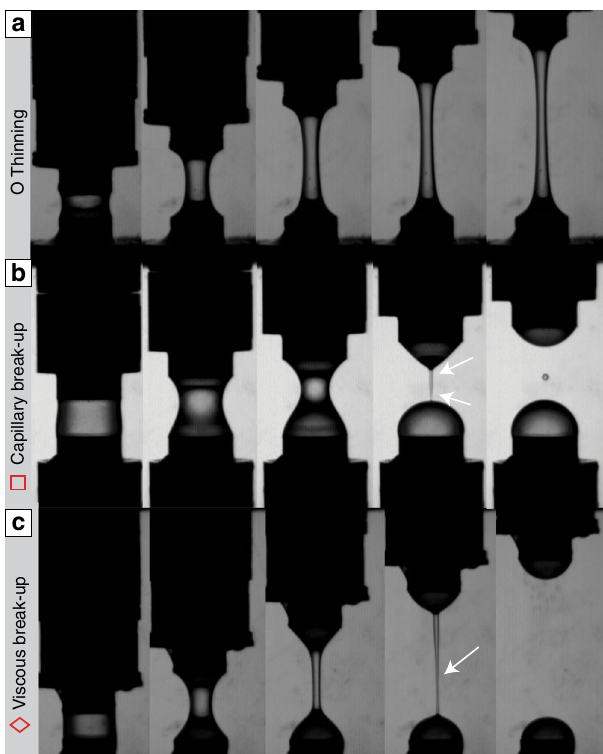
Fig. 2 Representative images showing the three styles of behaviour observed. Speci fi cally, these image stills are from experiments that used a a 5 wt.% dilution of golden syrup, b a 30 wt.% dilution of golden syrup and c a 20 wt.% dilution of golden syrup. Images taken at 0, 0.02, 0.04, 0.06 and 0.08 s into the deformation. In experiments a and c the initial droplet had a 4 mm diameter and 2 mm thickness and the sample was extended 14.65 mm over 0.1 s. For experiment b the initial droplet had a 5 mm diameter and 2.5 mm thickness and was extended 6.48 mm over 0.1 s. The white